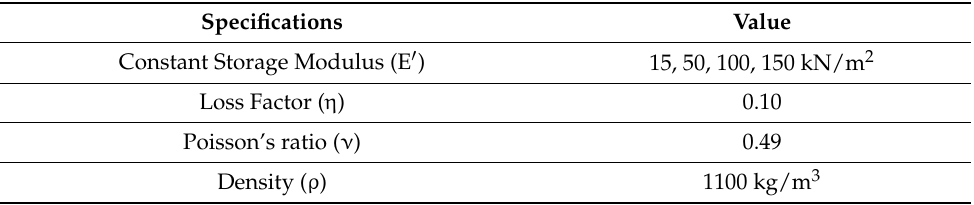
Table 4. Main parameters of the VEM Intermediate layer of the periodic